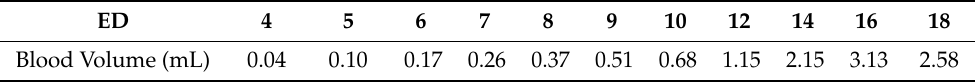
Table 1. Circulating blood volume (mL) in chick embryo on different embryonic days (EDs).